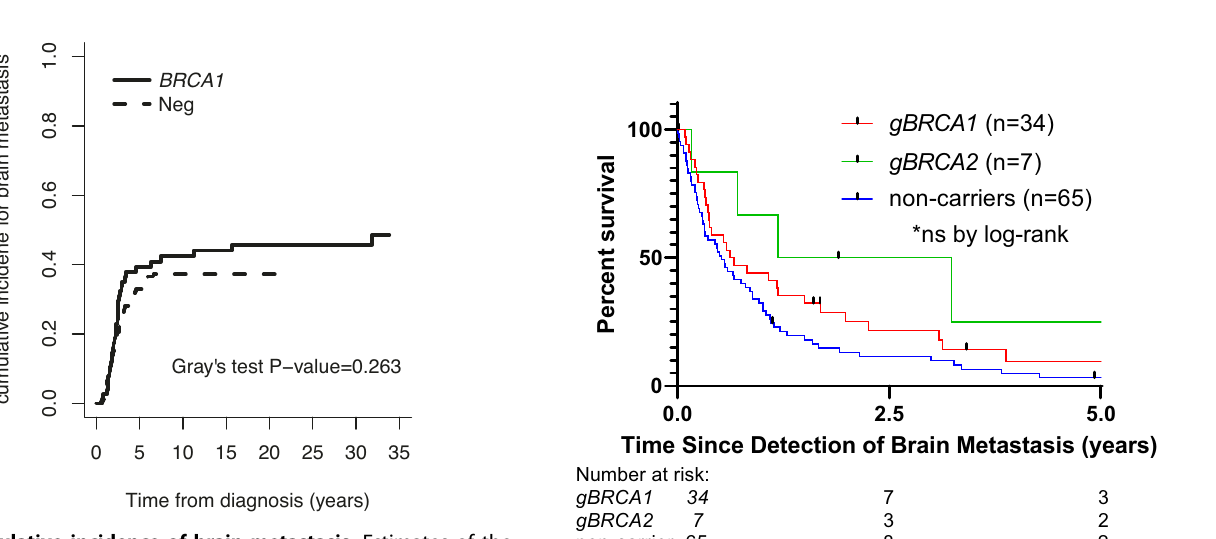
Fig. 2 Cumulative incidence of brain metastasis. Estimates of the cumulative incidence of brain metastasis are shown for gBRCA1 patients ( n = 76) and noncarriers with triple negative breast cancer ( n = 182) diagnosed with stage I-III disease with subsequent distant recurrence.